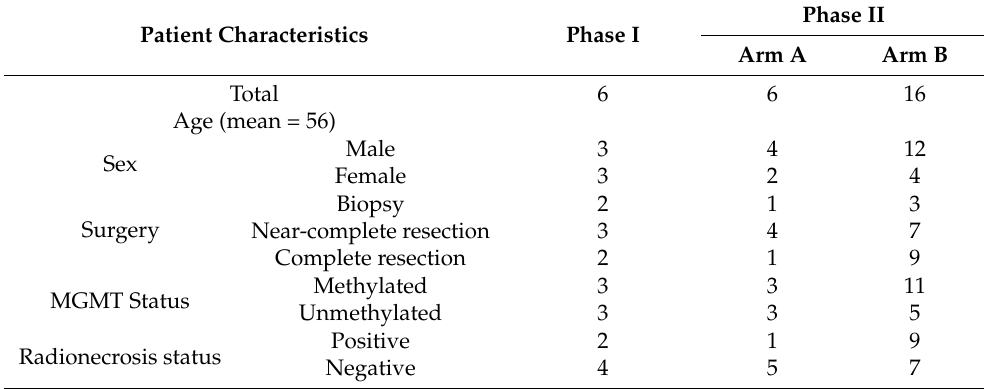
Table 1. Clinical characteristics of the patient population in the